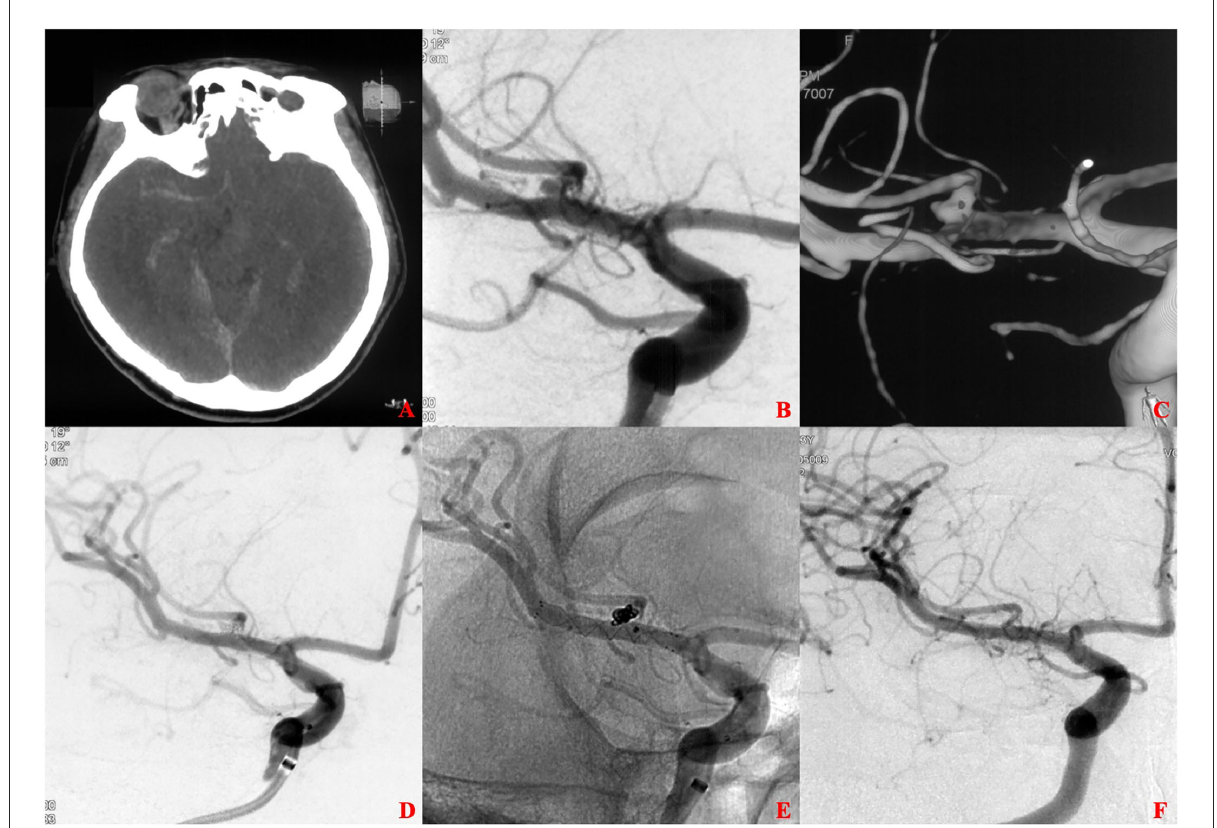
FIGURE1 A ruptured tiny middle cerebral artery (MCA) intracranial aneurysm treated with stent-assisted coiling (SAC). (A) The patient was admitted with spontaneous subarachnoid hemorrhage. (B,C) Cerebral angiography and 3D reconstruction revealed a tiny MCA bifurcation aneurysm. (D,E) The aneurysm was treated with SAC embolization using an LVIS stent (3.5 × 15mm). Immediate angiography showed that the aneurysm was completely occluded. (F) 13 months later, angiographic images showed complete occlusion of the aneurysm without in-stent artery